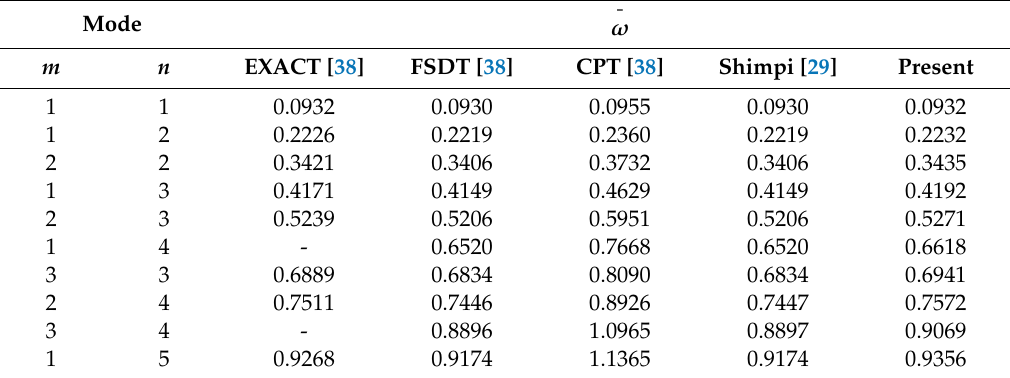
Table 4. Non-dimensional natural frequencies ω of simply supported boundary conditions (SSSS) isotropic square plate: a / h = 10; b = a .